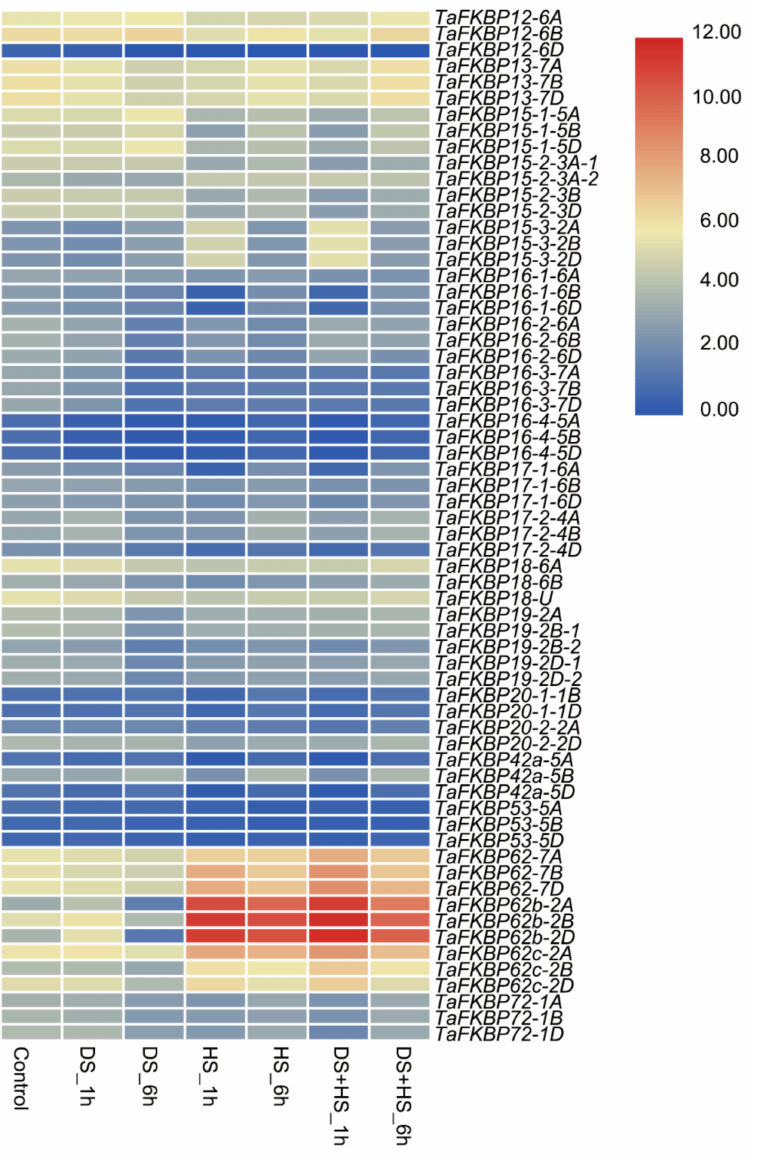
Figure 8. Heatmap representing the expression patterns of TaFKBP genes under heat and drought stresses. TPM values were directly used to create the heatmap. DS: drought stress, HS: heat stress, DS+HS: drought stress plus heat